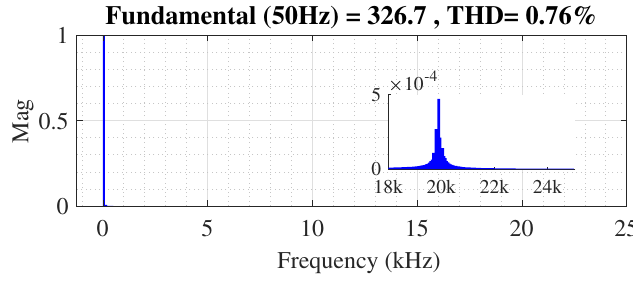
Figure 15. Output voltage THD.